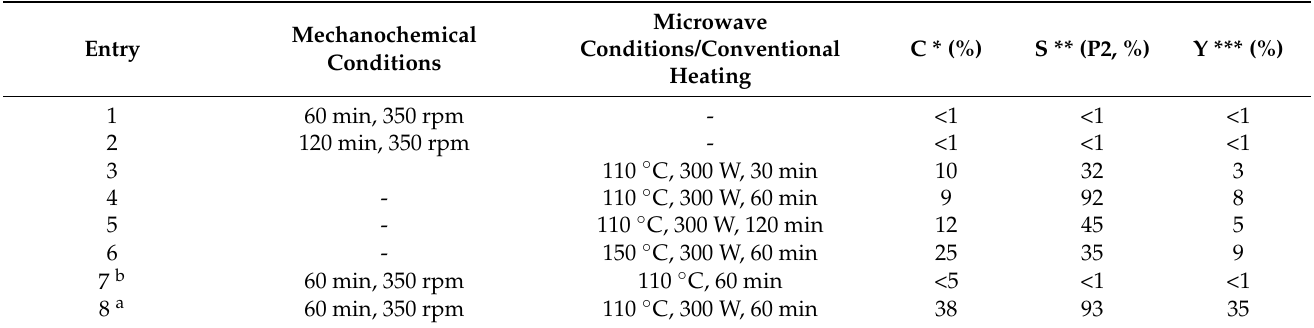
Table 1. Performance of reactions of 2-aminophenol and glycerol, employing K 2 CO 3 . Quantification analysis was performed from GC-MS results.